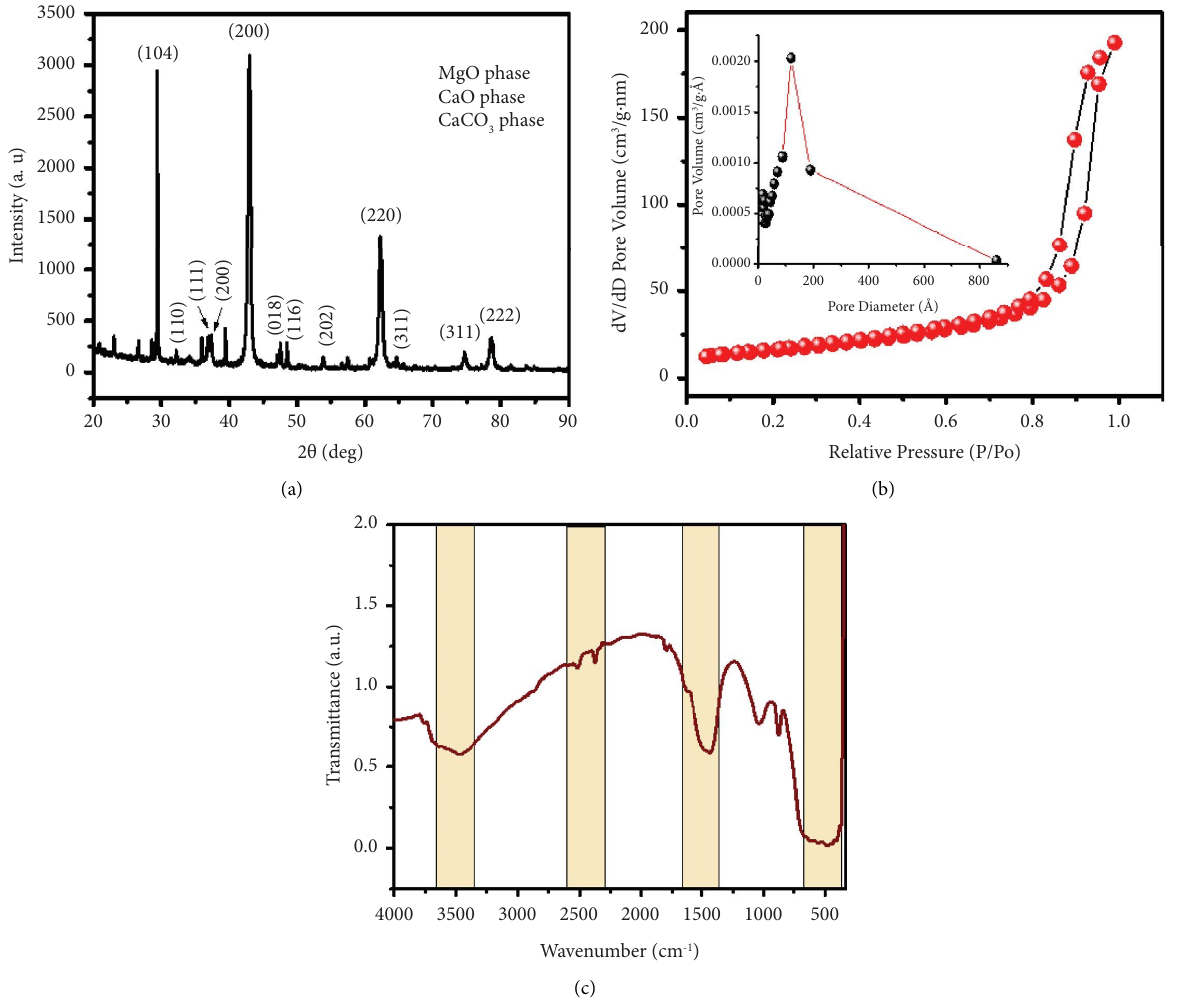
Figure 1: Characterization of Ca-MgO nanosorbent. (a) XRD pattern, (b) BET isotherm (inset pore distribution), and (c) FTIR of the fabricated CaO.MgO